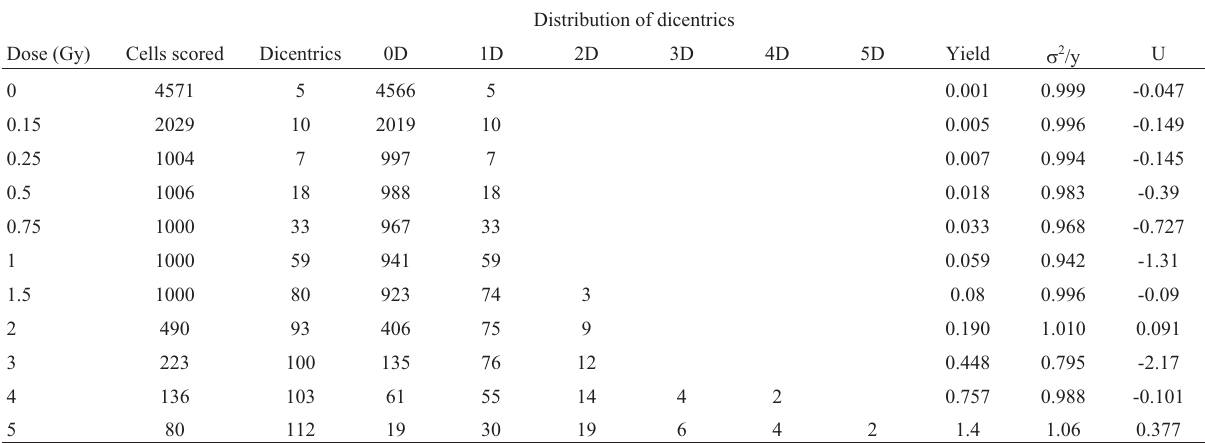
Distribution of